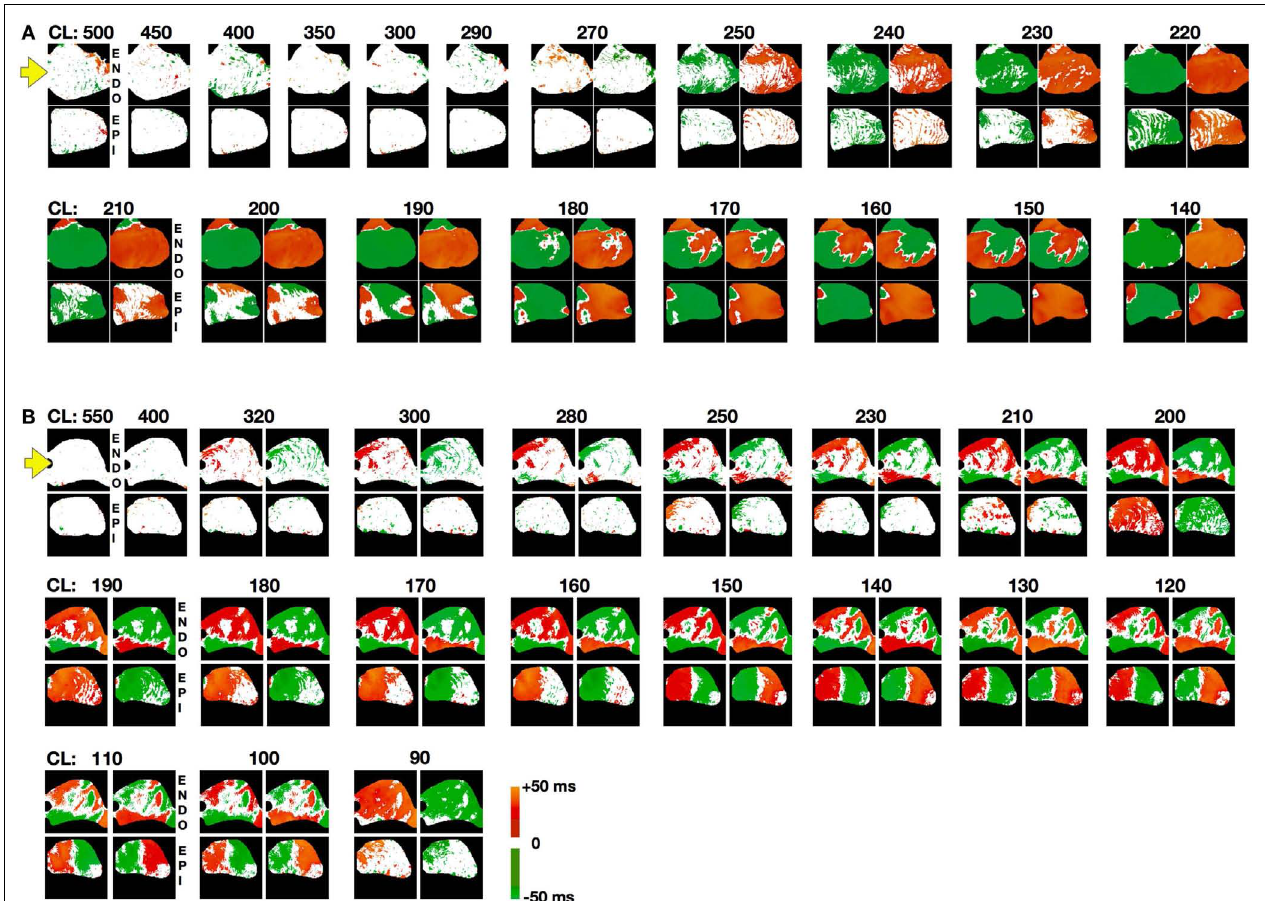
and that there was no apparent correlation between the two surfaces.Yellow arrow indicates pacing site. Color code refers to alternans maps amplitude with 10 intervals of 5ms: no alternating regions (white), positive intervals ( + [0:50]ms; red to yellow), negative intervals ( − [0:50]ms) (blue to green). Steady state was reached for each CL by pacing for 60s followed by recording for an additional